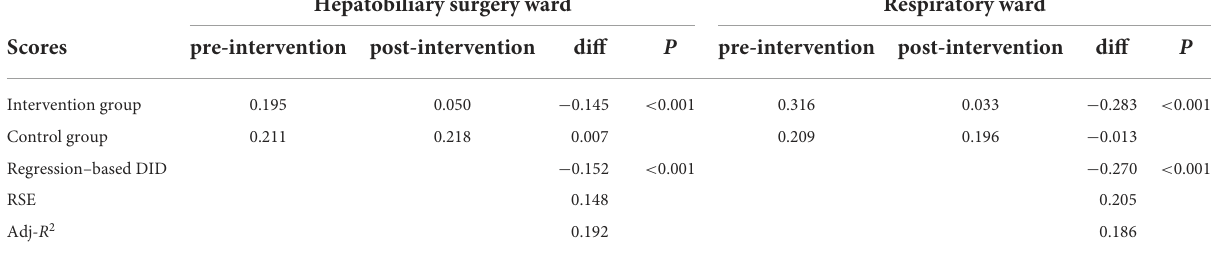
TABLE 5 Mean of the scores of rationality evaluation of antibiotics and DID results in two wards. Hepatobiliary surgery